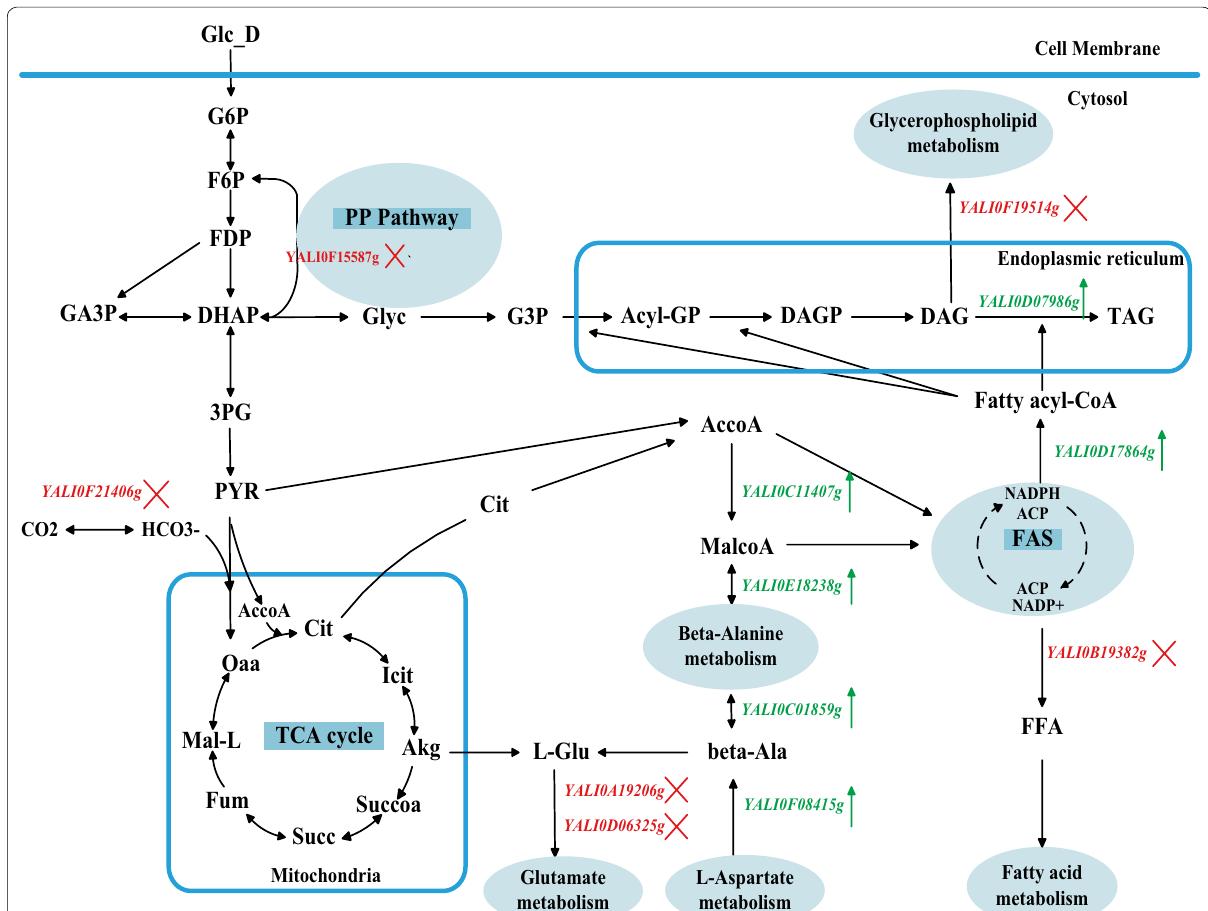
Fig. 3 Overview of different pathways involved in TAG synthesis in model iYL_2.0. Metabolite abbreviations are shown in black and genes in red or green. The genes in red are knockout targets identified by OptGeneKnock and IdealKnock, the genes in green are overexpression targets identified by APGC. Metabolite abbreviations: Glc_D, d -glucose; G6P, d -glucose 6-phosphate; F6P, d -glucose 6-phosphate; FDP, d -fructose 1,6-bisphosphate; DHAP, Glycerone phosphate; GA3P, d -glyceraldehyde 3-phosphate; 3PG, d -glycerate 3-phosphate; PYR, pyruvate; Oaa, oxaloacetate; Cit, citrate; Icit, isocitrate; Akg, 2-oxoglutarate; Succoa, succinyl-CoA; Succ, succinate; Fum, fumarate; Mal-L, l -malate; AccoA, Acetyl-CoA; MalcoA, Malonyl-CoA; beta-Ala, beta-alanine; L-Glu, l -glutamate; Glyc, glycerol; G3P, sn-glycerol 3-phosphate; Acyl-GP, 1-acyl-sn-glycerol 3-phosphate; DAGP, 1,2-diacyl-sn- glycerol 3-phosphate; DAG, diacylglycerol; TAG, triacylglycerol; ACP, acyl-carrier